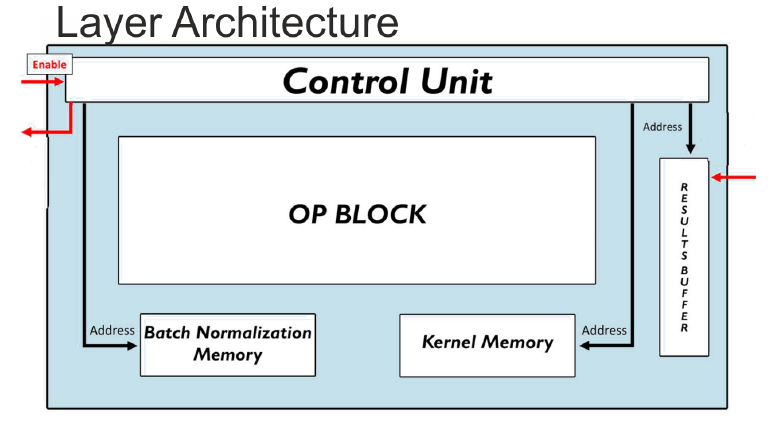
Figure 6. Block scheme of the layers.